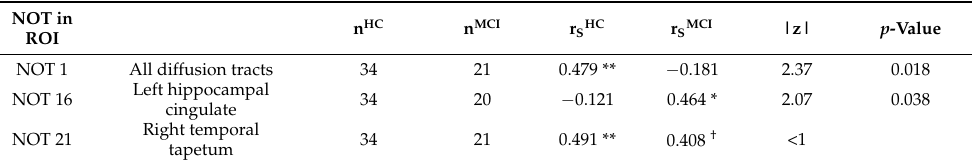
Table 6. Significant correlations between number of tracts (NOT) and MoCA scores in older healthy controls (HC) and older adults with mild cognitive impairment (MCI).